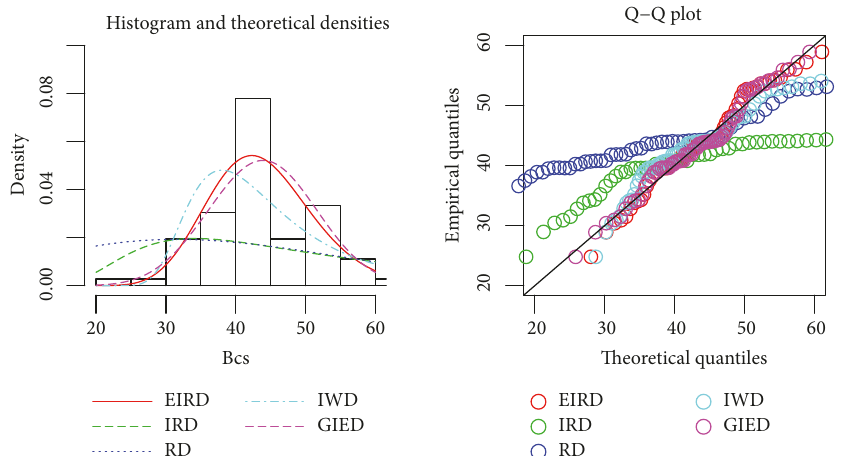
Figure 5: Histograms and theoretical densities and Q-Q plot for BCS.